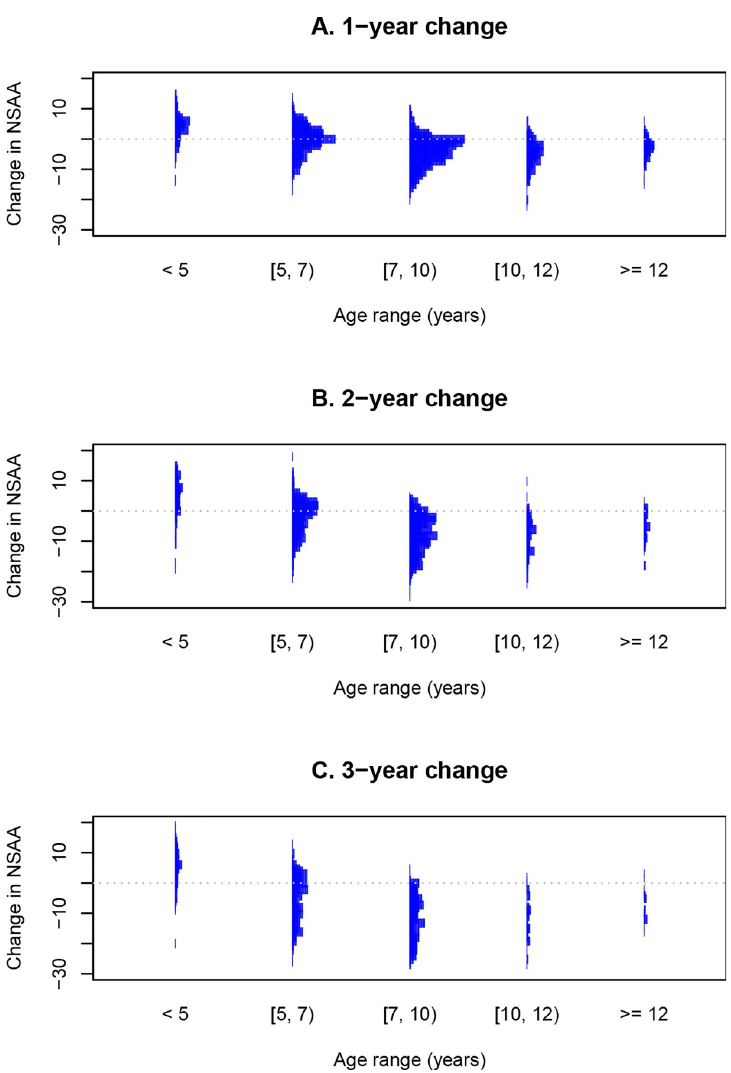
Fig 2. Histograms of changes in NSAA total scores over (A) 1 year, (B) 2 years, and (C) 3 years among boys with DMD belonging to different age ranges. DMD, Duchenne muscular dystrophy; NSAA, North Star Ambulatory